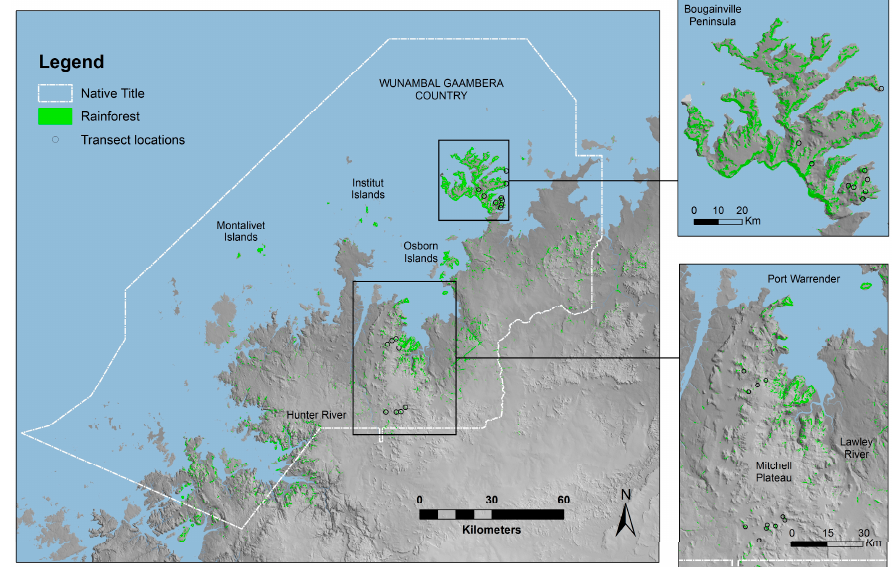
Figure 2. A map of rainforest patches in WGC. Insets show areas of high patch size and density at the Bougainville Peninsula and Mitchell Plateau, including transect locations. Note that patch size has been enhanced to better illustrate patch distribution at map scale.